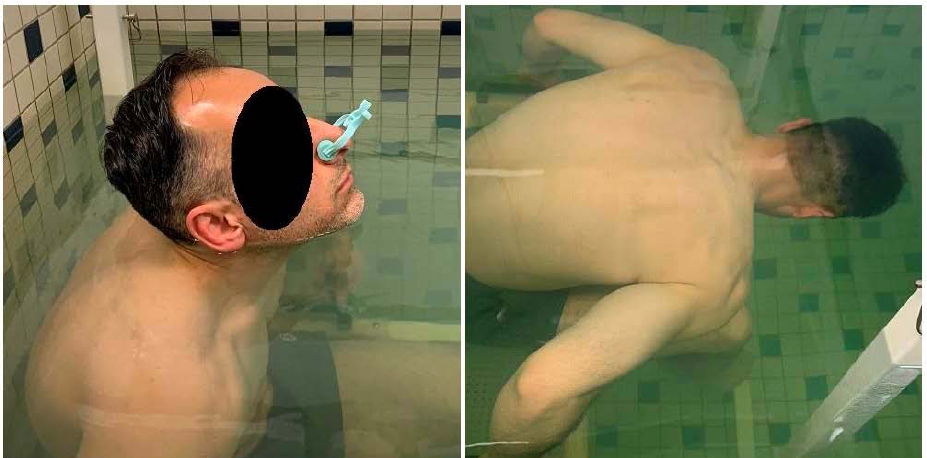
Figure 2. Subject in hydrostatic weighing tank partially immersed with head above water (left) and completely immersed with head below water (right).